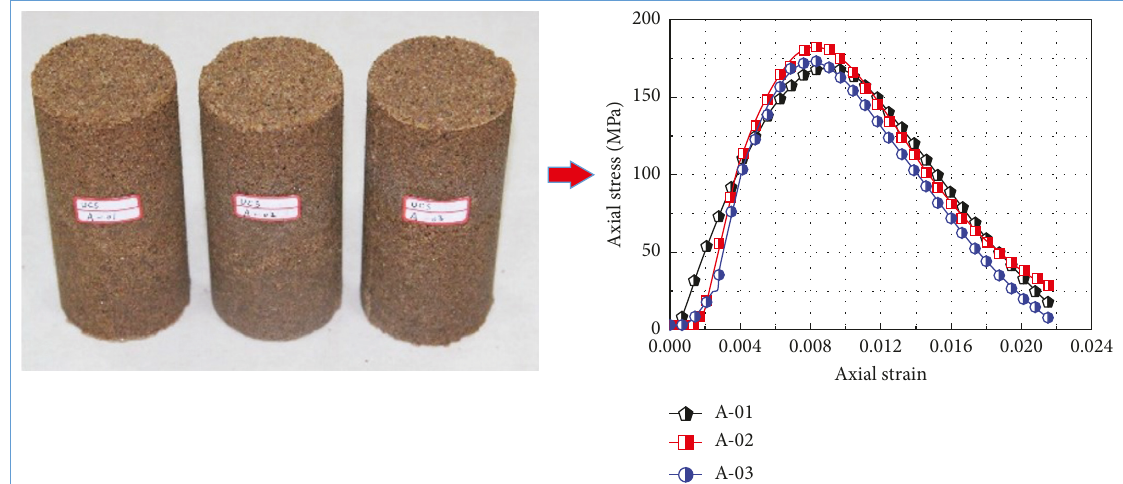
Figure 3: Standard samples and stress-strain curve.